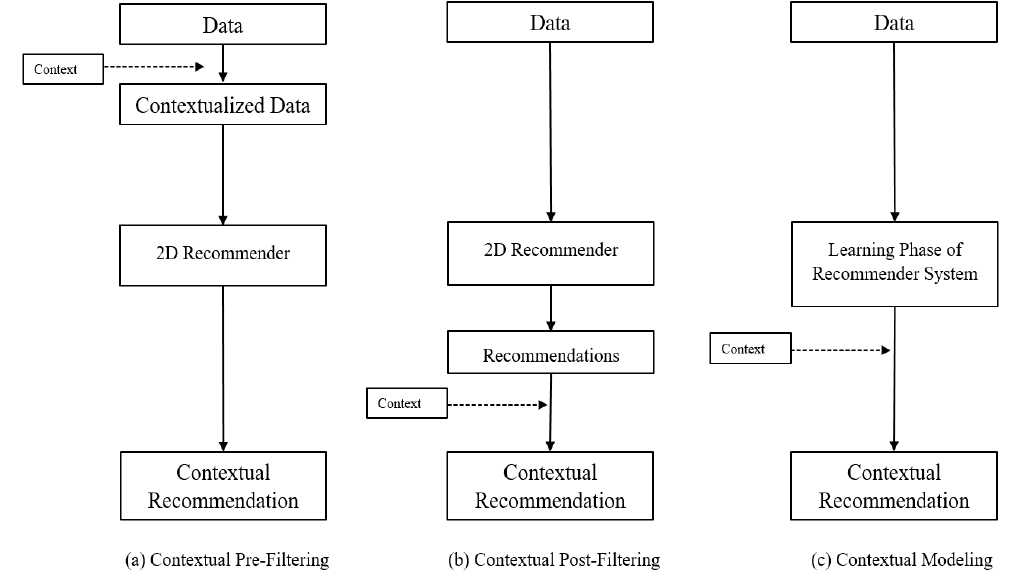
Figure 1. Incorporation of contextual information in the recommendation process. ( a ) Pre-filterining approch; ( b ) Post-filterining approch; ( c ) Contextual